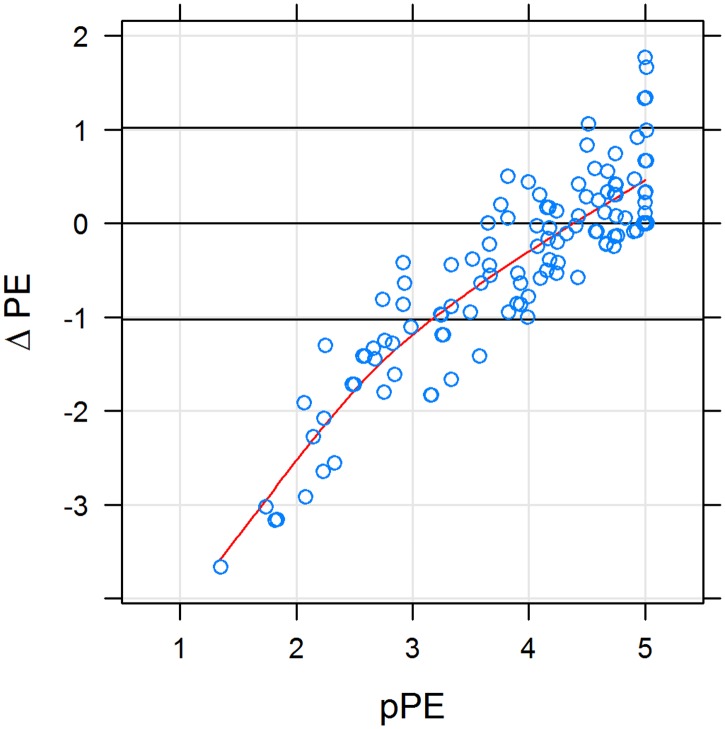
Difference between desired and perceived physician empathy (ΔPE) as a function of perceived physician empathy (pPE).X-Y scatterplot; horizontal lines denote equality between desired and perceived physician empathy plus or minus 1 standard deviation. Red curve is a cubic spline fit. Perceived physician empathy and ΔPE were strongly correlated (Spearman’s rho = 0.83; p < 10−15). Desired and perceived physician empathy were balanced if perceived physician empathy was > 4. In 28 subjects, ΔPE was 1 SD below zero, and in 5 cases it was 1 SD above.